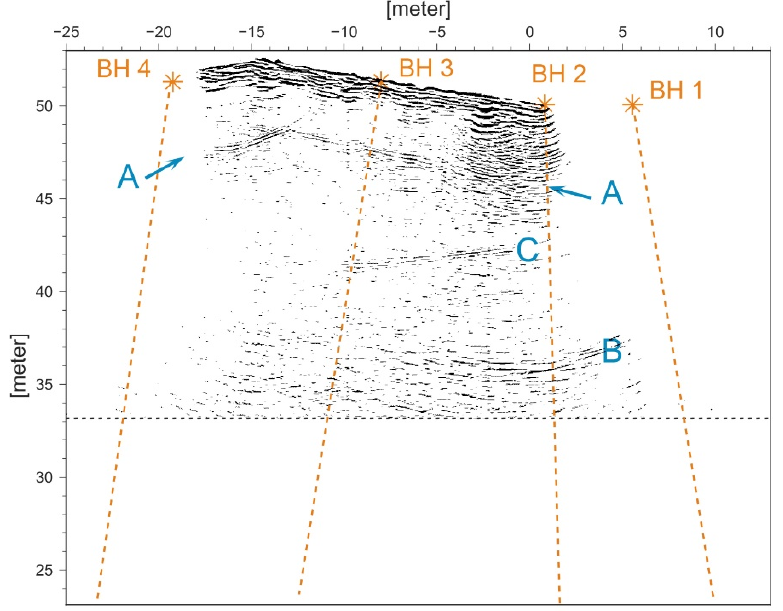
Figure 5. 250 MHz antenna—letters described in text.